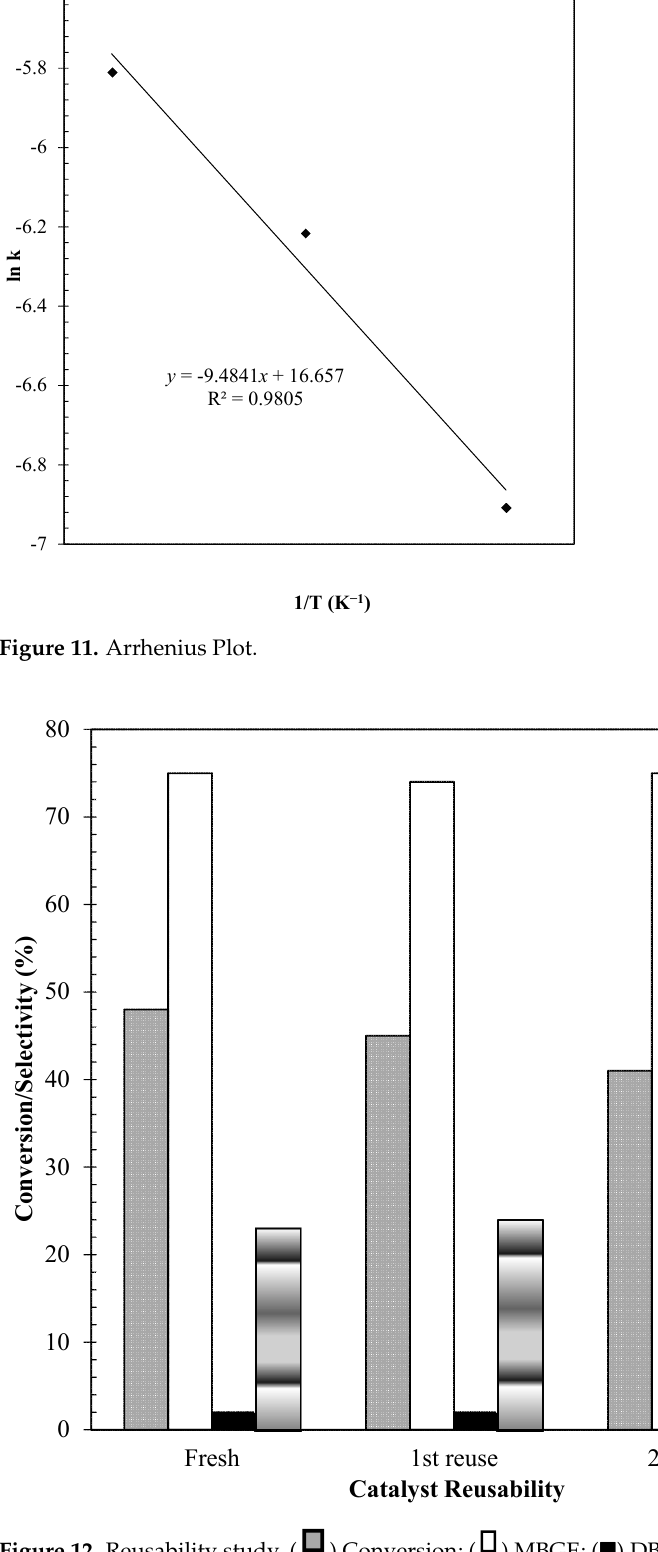
Figure 12. Reusability study. (